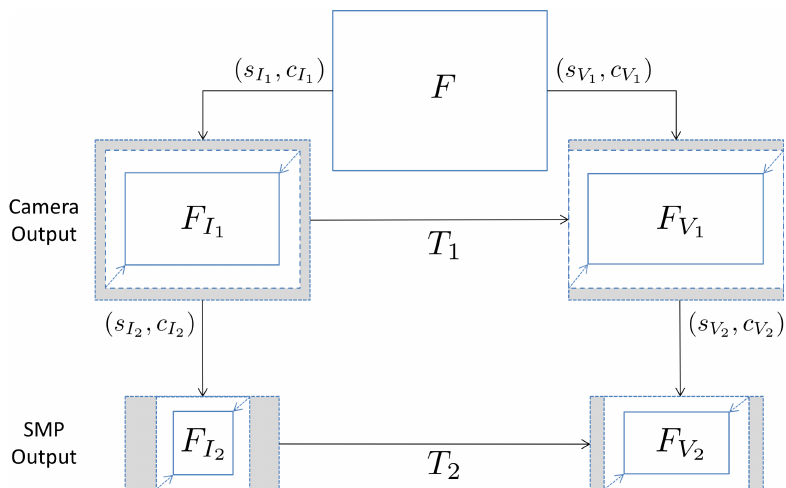
Figure 3. Workflow of the geometric transformation applied to the sensor noise. From the full frame F , an image F I 1 or video F V 1 is acquired by the camera, and exchanged through a Social Media Platform (SMP) creating F I 2 or F V 2